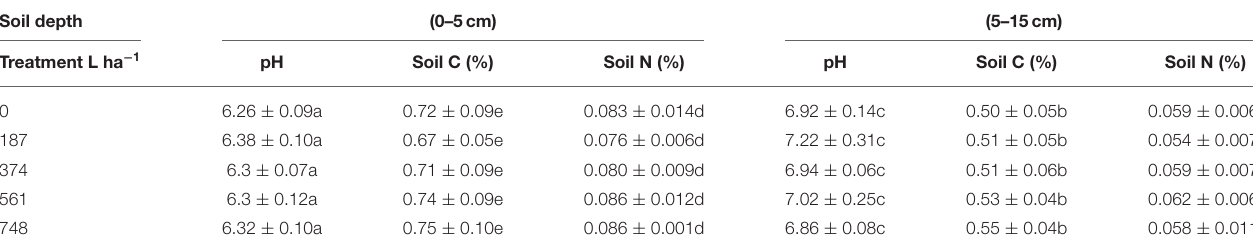
TABLE 2 | Effect of lactobionate application rates on soil pH, soil C, and N across soil depths (0–5, 5–15cm) for the corn field trial. Soil depth